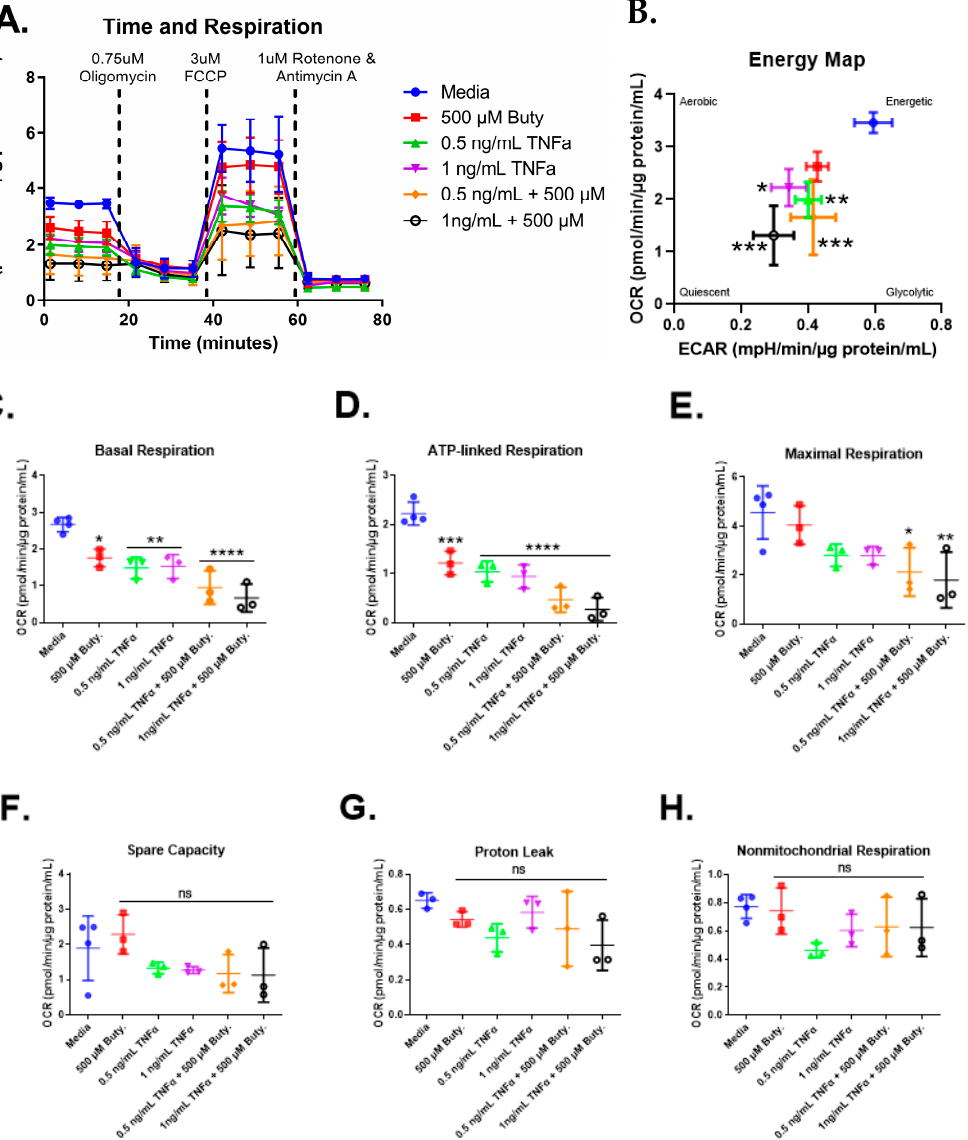
Figure 7. Normalized oxygen consumption rate for primary rat colon epithelial cells after 24 h exposure to butyrate and TNF α . ( A ) Oxygen consumption rates over time, ( B ) energy map, ( C ) basal respiration, ( D ) oligomycin-induced ATP-linked respiration, ( E ) FCCP-induced maximal respiration, ( F ) spare capacity, ( G ) proton leak, and ( H ) non-mitochondrial respiration. Data are presented as mean ± standard deviation. Asterisks indicate degree of significance from medium control (One-way ANOVA followed by a Dunnett’s multiple comparison test, n = 3 or 4; significance determined at * = p < 0.05, ** = p < 0.01, *** = p < 0.001, **** = p < 0.0001).